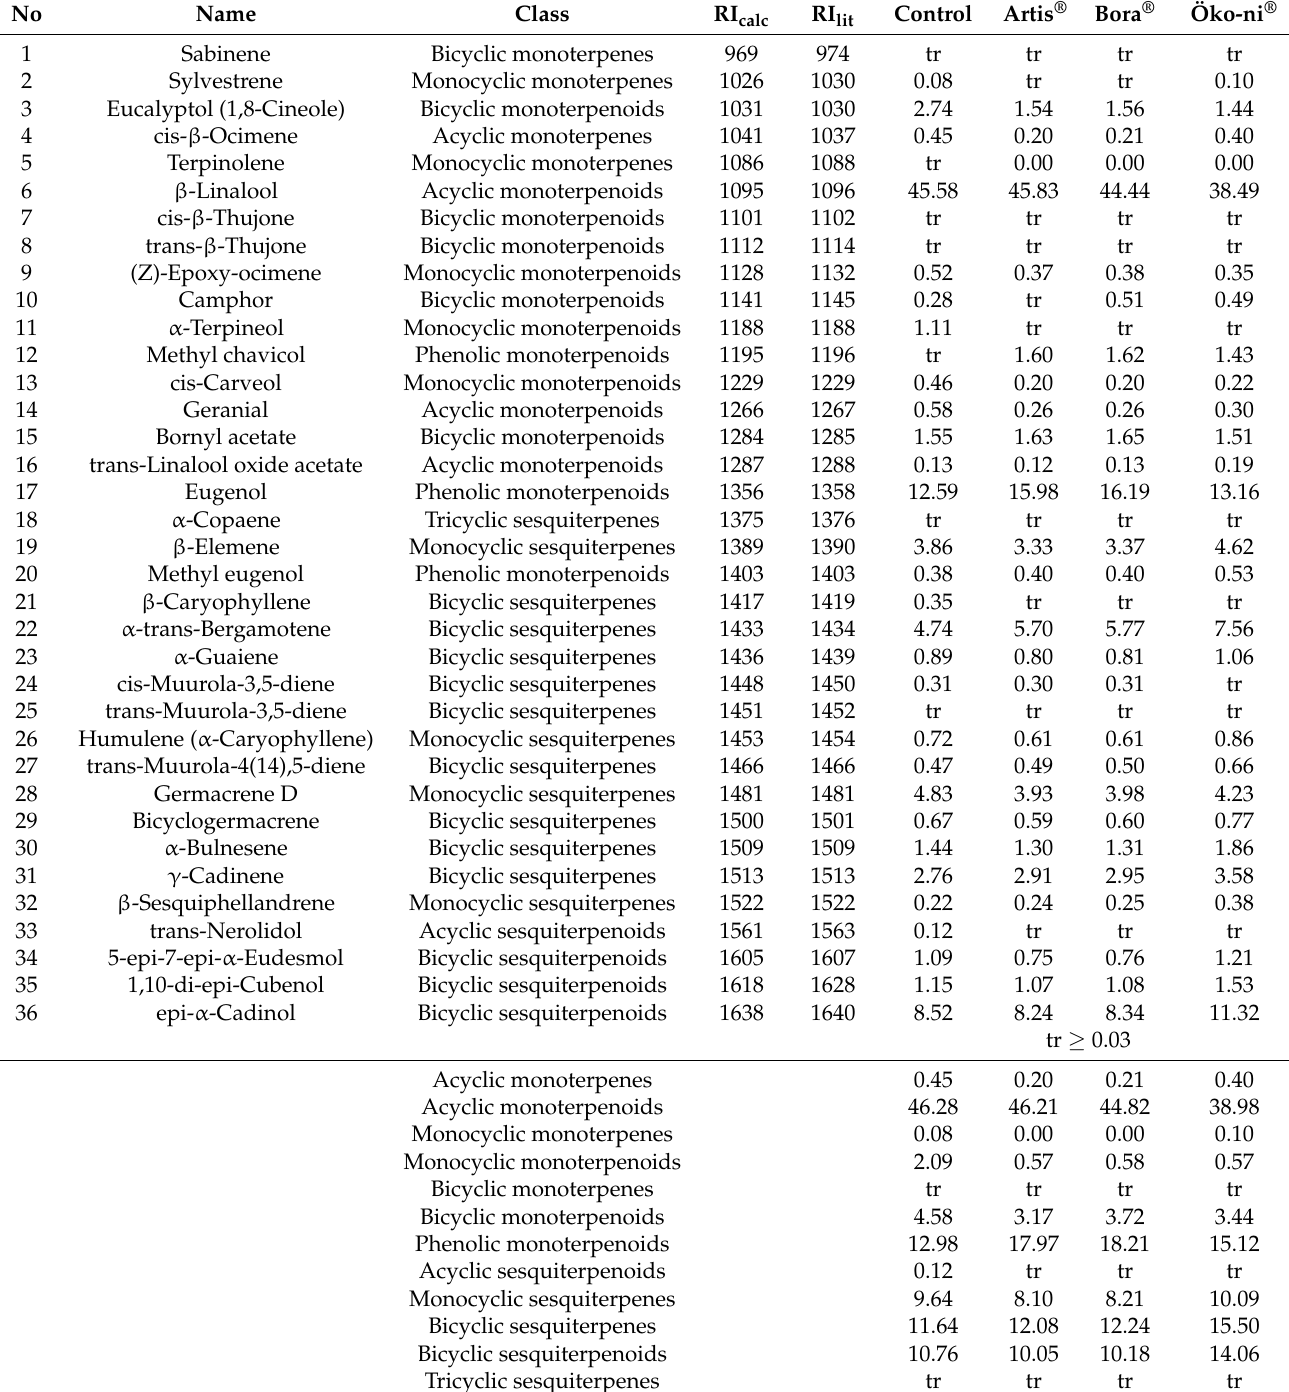
Table 7. Influence of myco-biocontrol formulates on essential oil composition of